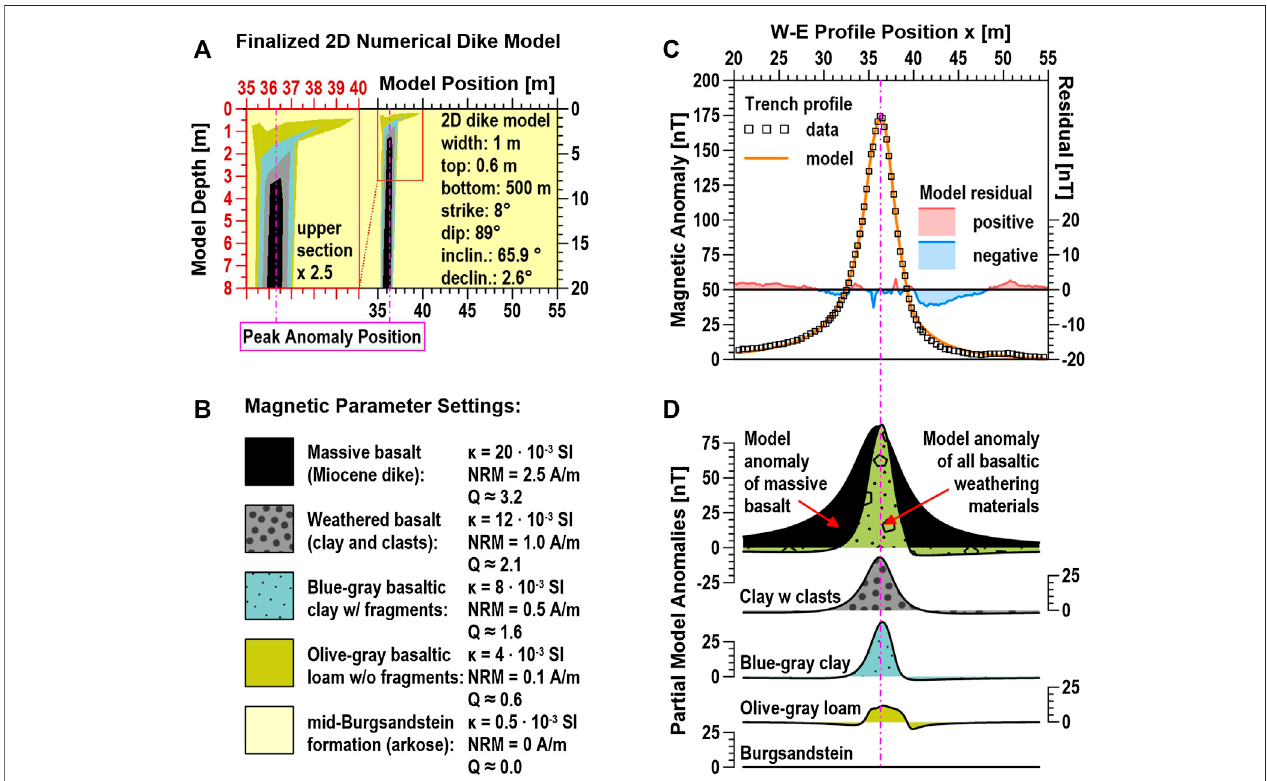
FIGURE3|(A) 2DmodelofweatheredHDSdikebasedonthesimpli fi edandextrapolatedexplorationtrenchsectionof Figure2 .Shownatleft(redaxes)isa2.5x enlarged view of the dike top; the smaller model at right (black axes) is scaled proportionally with Figure 3C . (B) Distinguished model materials, their color patterns and magnetic properties. (C) Total 2D dike model anomaly (orange line) and corrected ground magnetic survey anomaly data (squares) with model residuals (note vertical offset and expanded scaling of residual axis). (D) 2D model-based partial magnetic anomalies of pristine basalt (black), all weathering materials (olive green), and speci fi c anomaly contributions by each material classi fi ed in Figure 3B . All anomaly axes are equivalently scaled in